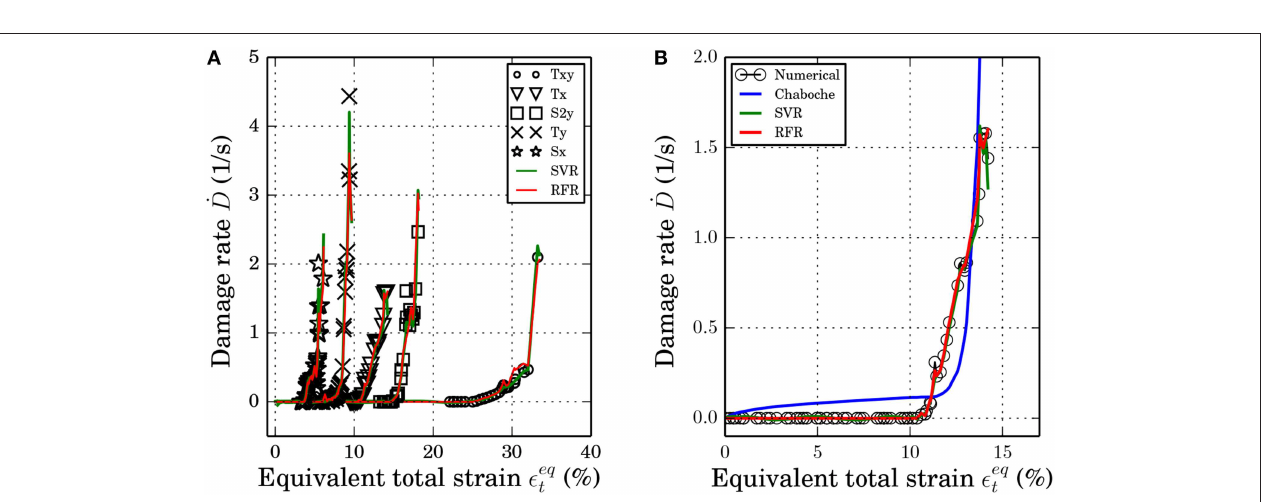
FIGURE 8 | ML results with numerical data, SVR and RFR results plotted in a damage rate against total equivalent strain plot (A) for different loading states: uniaxial tension in x- and y-direction: Tx and Ty, biaxial tension: Txy, shearing in x- and y-direction: Sx and S2y (Numerical data points before damage initiation are not plotted) and (B) compared to the analytical damage model according to Equation (25) with the parameters s tension in x-direction.